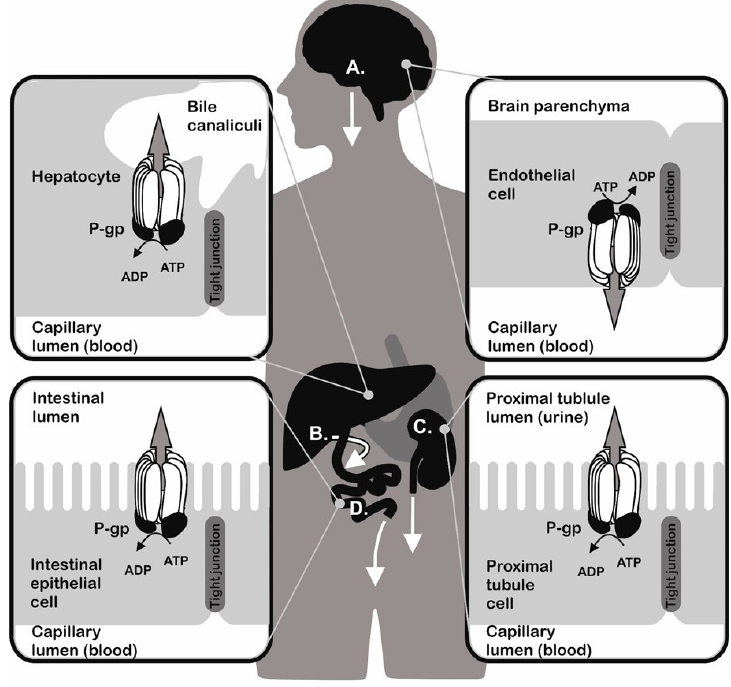
Figure 1. Biological function of P-glycoprotein (P-gp) in various tissues. ( A ) The blood-brain barrier separates blood circulating in the brain capillaries from the brain tissue. P-gp is one of the blood-brain barrier components and is localized on the luminal side of brain micro-capillary endothelial cells, where it prevents the penetration of xenobiotics through the endothelium to brain tissue; ( B ) P-gp promotes the excretion function of liver by transporting substances with limited solubility in water and their metabolites formed by enzymes of the first and second phase of liver detoxification machinery from hepatocytes into the bile; ( C ) P-gp in the proximal tubule cells of the nephrons secures elimination of water soluble substances via urine; ( D ) The gut blood barrier prevents the absorption of pathogens and toxins from diet [21,22]. P-gp is localized in the mucosal cells of the small intestine and promotes the integrity of the gut blood barrier by pumping harmful substances into the lumen of the intestines.